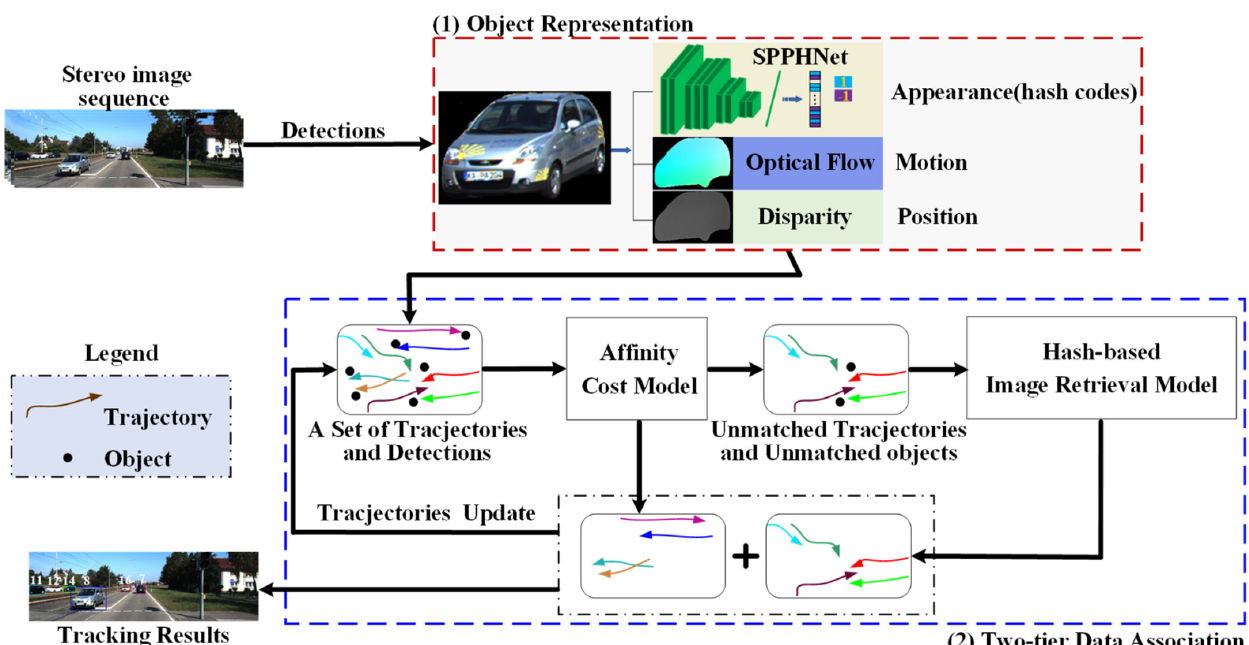
Figure 1. The framework of our proposed MOT method. (1) Object representation (in the red dashed box). (2) data association (in the blue dashed box).